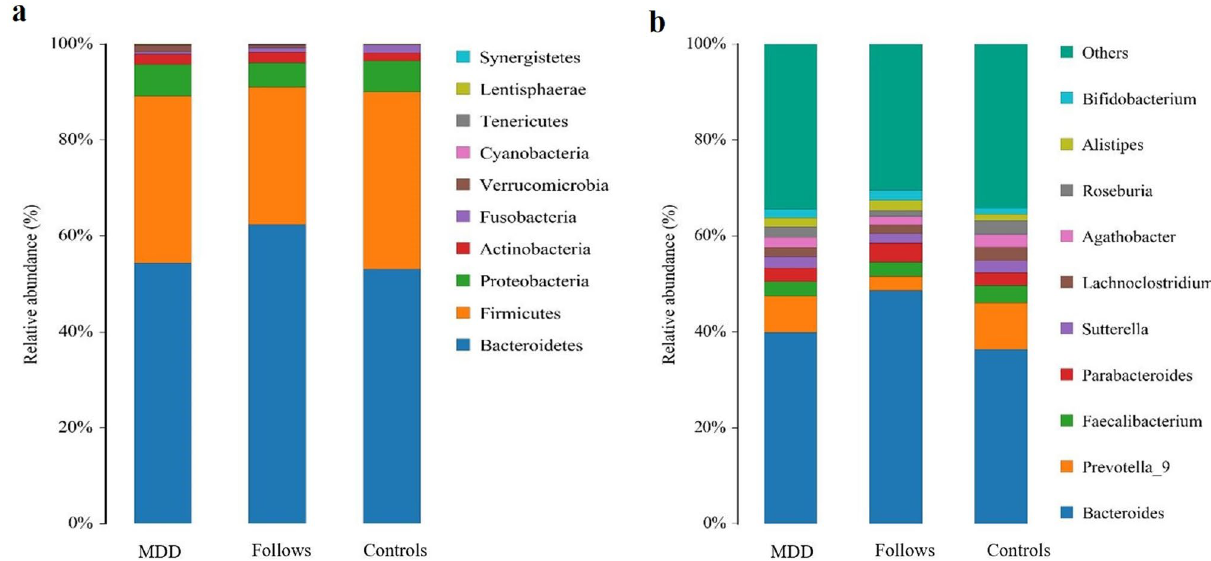
Figure 1. Histogram of species distribution. QIIME software was used to generate species abundance tables at different taxonomic levels, and R language tool was used to draw community structure charts at different taxonomic levels. ( a ) Relative proportions of species distribution at the phylum level; ( b ) relative proportions of species distribution at the genus